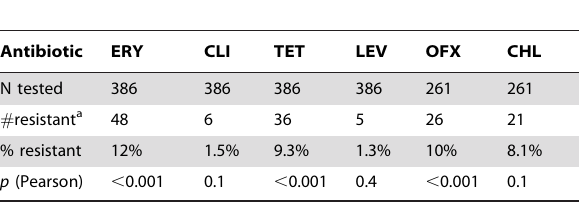
Table 6. Rates and significance of nonrandom distribution by PCR/ESI-MS emm